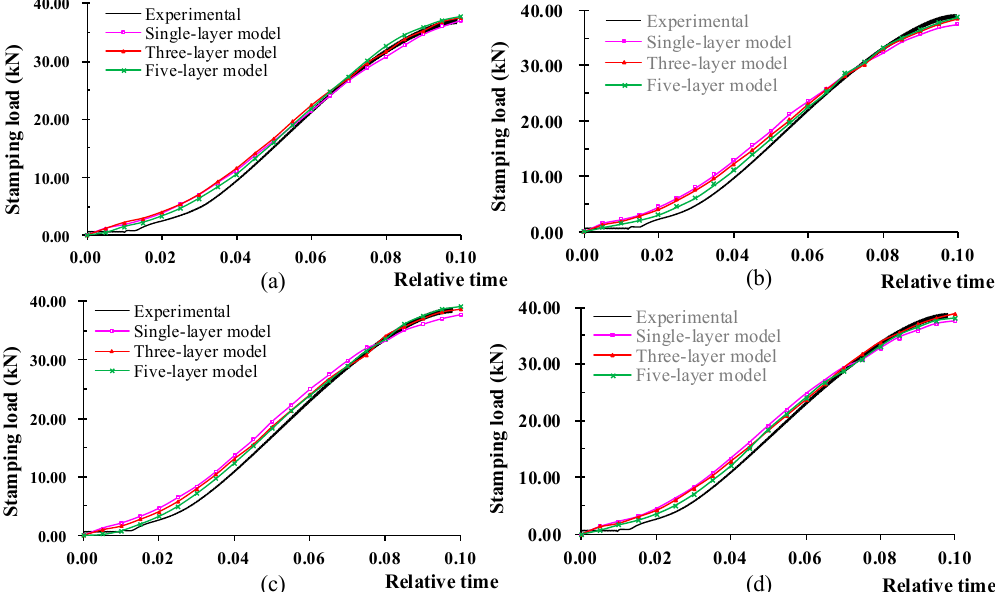
Figure 17. Stamping force history comparative between numerical simulation results of different element models and experimental results: ( a ) Blank holder force 50 kN, punch stroke 9.76 mm, ( b ) Blank holder force 115 kN, punch stroke 10.25 mm, ( c ) Blank holder force 170 kN, punch stroke 10.75 mm, ( d ) Blank holder force 200 kN, punch stroke 10.45 mm.